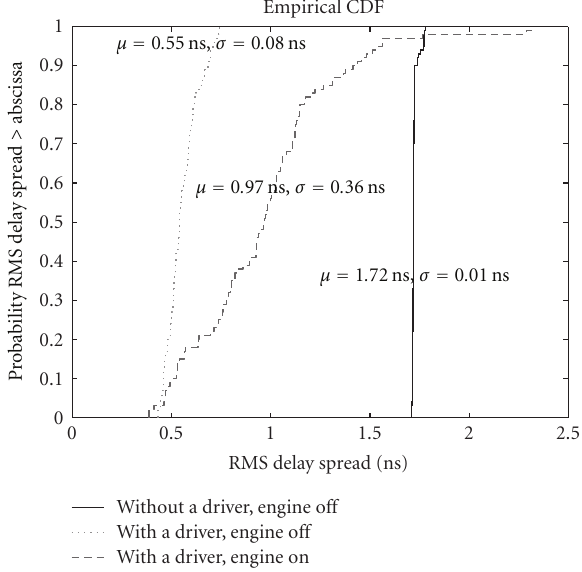
Figure 12: CDFs of the measured RMS delay spreads for Rx12 (LOS) in the UWB band measurements in all three